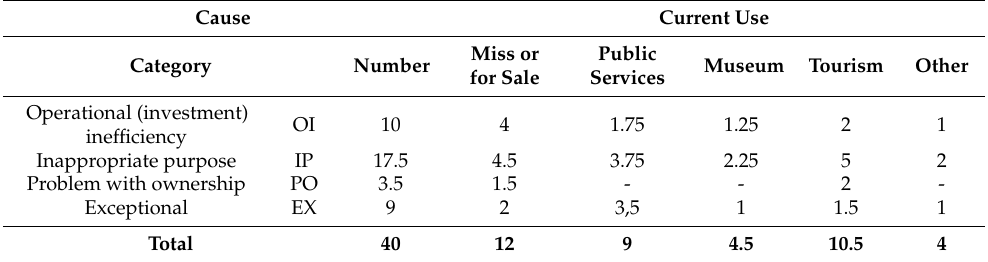
Table 4. Cause of brownfield, length of abandonment (in years), and new purpose